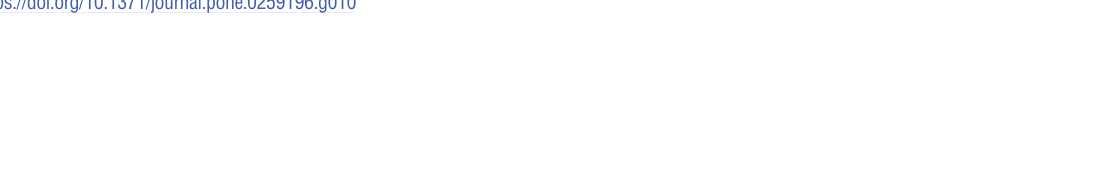
PLOS ONE | https://doi.org/10.1371/journal.pone.0259196 November3,